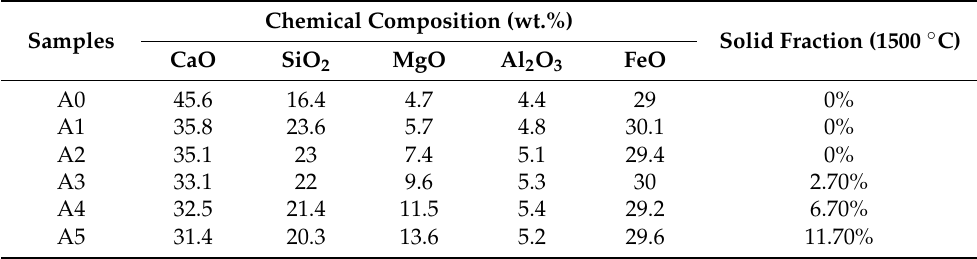
Table 1. Slag compositions of this study.